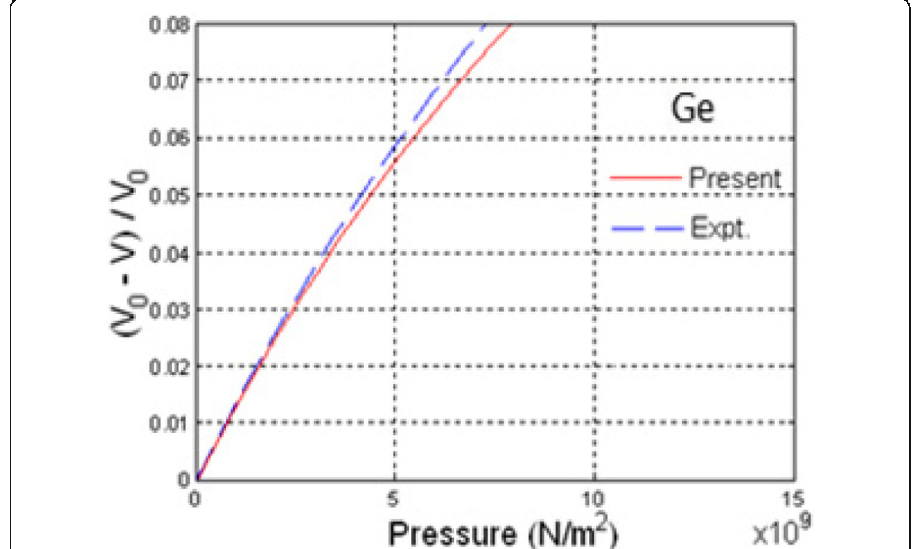
Fig. 3 The dependence of volume ratio ( V 0 - V )/ V 0 on pressure P in the equation of state for a germani